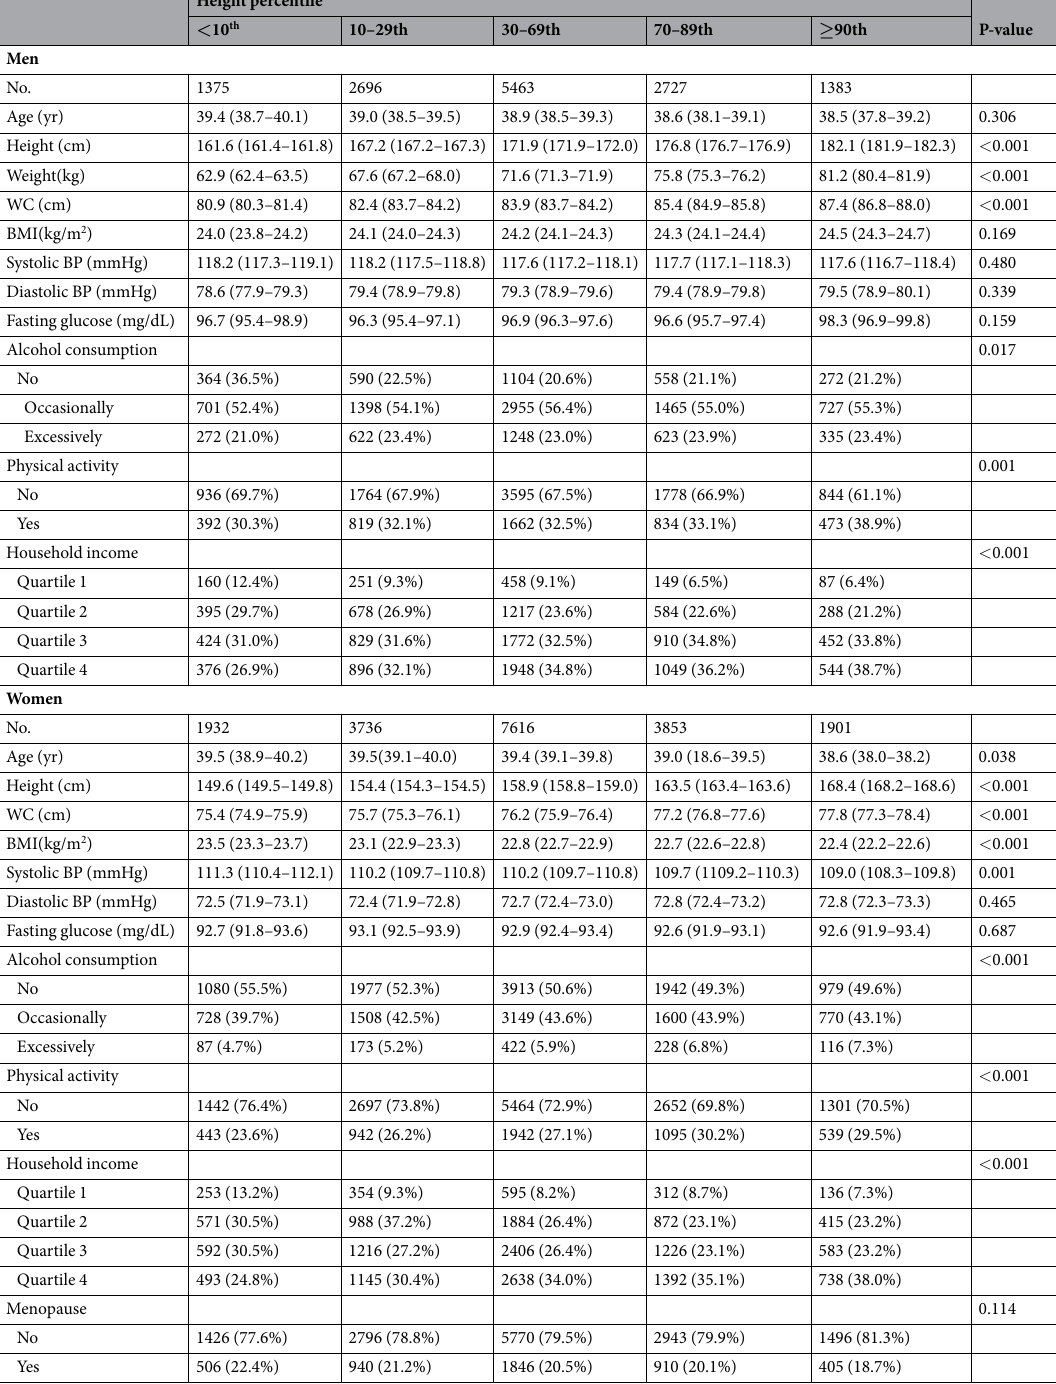
Table 2. General characteristics of the subjects according to the height percentile in 32,682 adults. The data were present as mean (95% confidence interval) or number (%). All continuous variables were adjusted for age in women. BMI, body mass index; BP, blood pressure; WC, waist